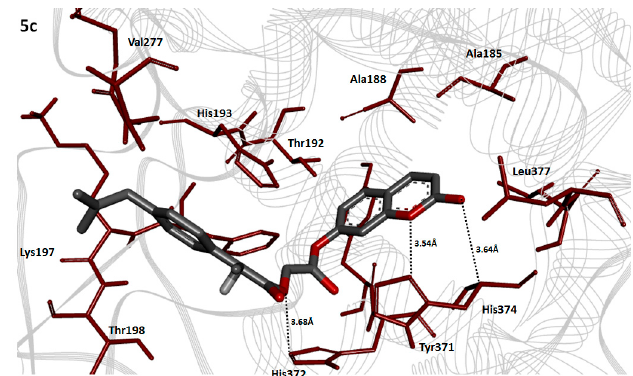
Figure 6. Docking interactions of ( 5c ) with receptor. The COX-2 protein chain is highlighted in light grey color in wire format. The dark grey color showed the ligand structure while the embedded red colors showed oxygen moiety. The binding pocket interacted residues are highlighted in dark red color and black dotted lines justify the hydrogen bondings. Two hydrogen binds were observed with HIS374 at a distances of 3.64 and 3.54 Å and one with HIS372 at a distance 3.68 Å, respectively.